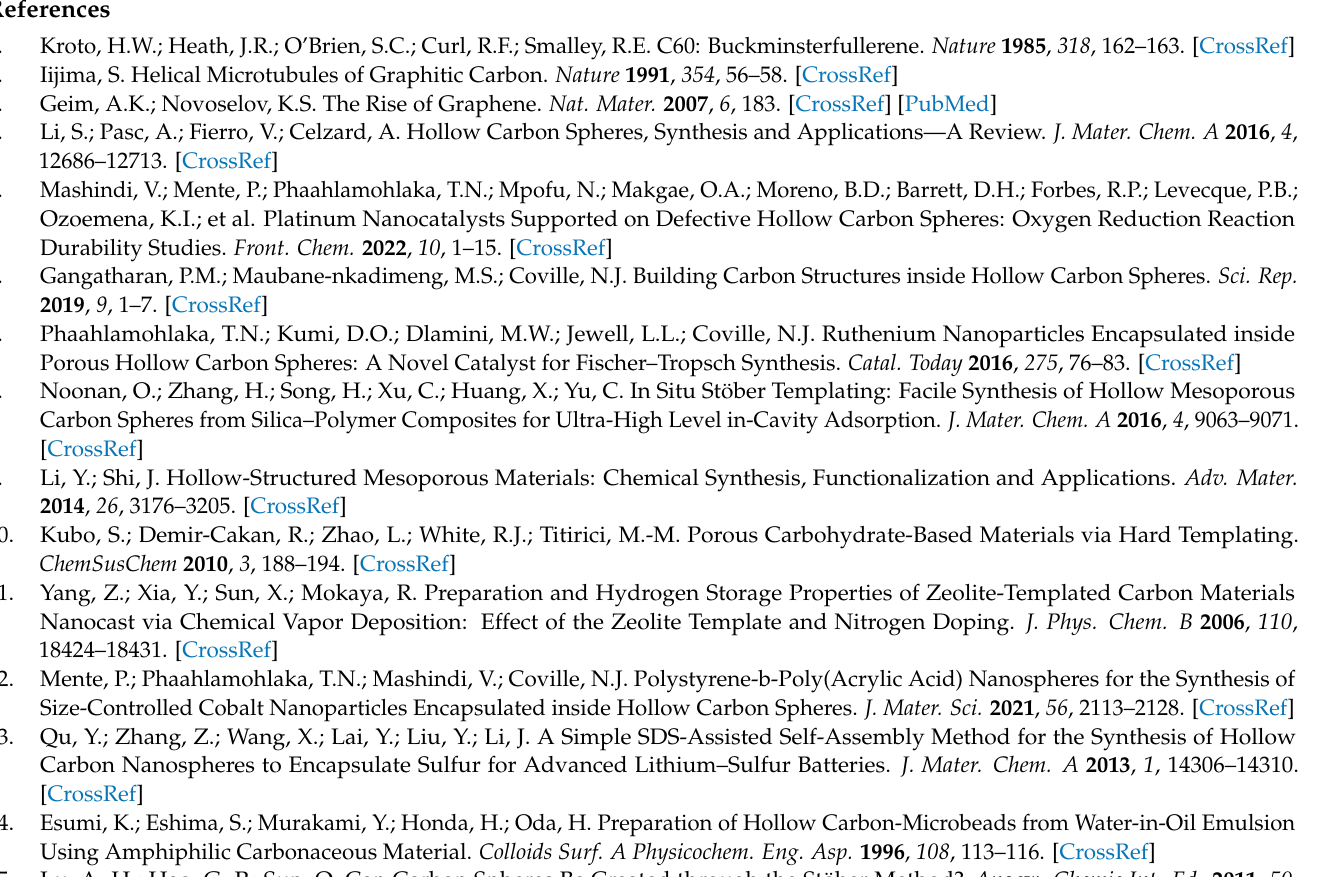
coating. Table S1: Morphological parameters based on TEM micrographs; Table S2: Thermal stability properties of pristine and Ni@HCSs